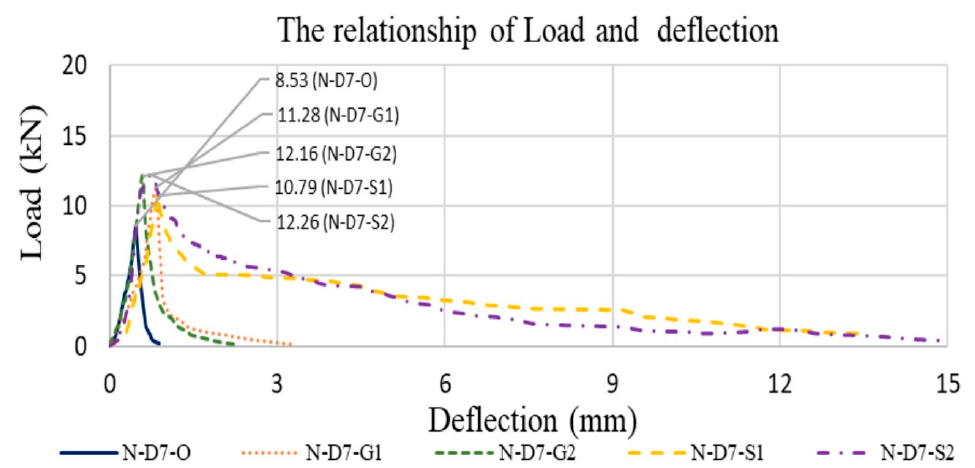
Figure 16. Flexural load and displacement diagram for ordinary-fiber pervious concrete.